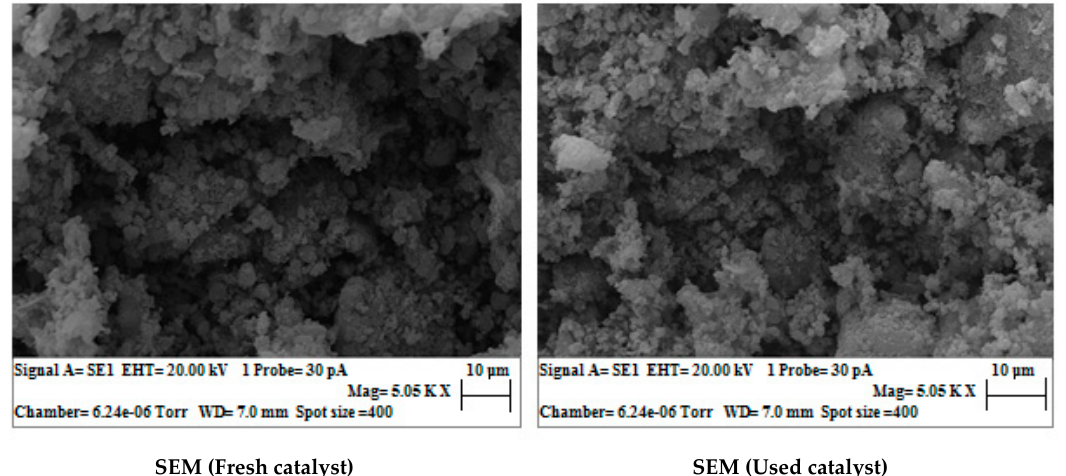
Figure 6. The TEM and SEM images of the fresh and spent catalysts obtained from complex 2 .